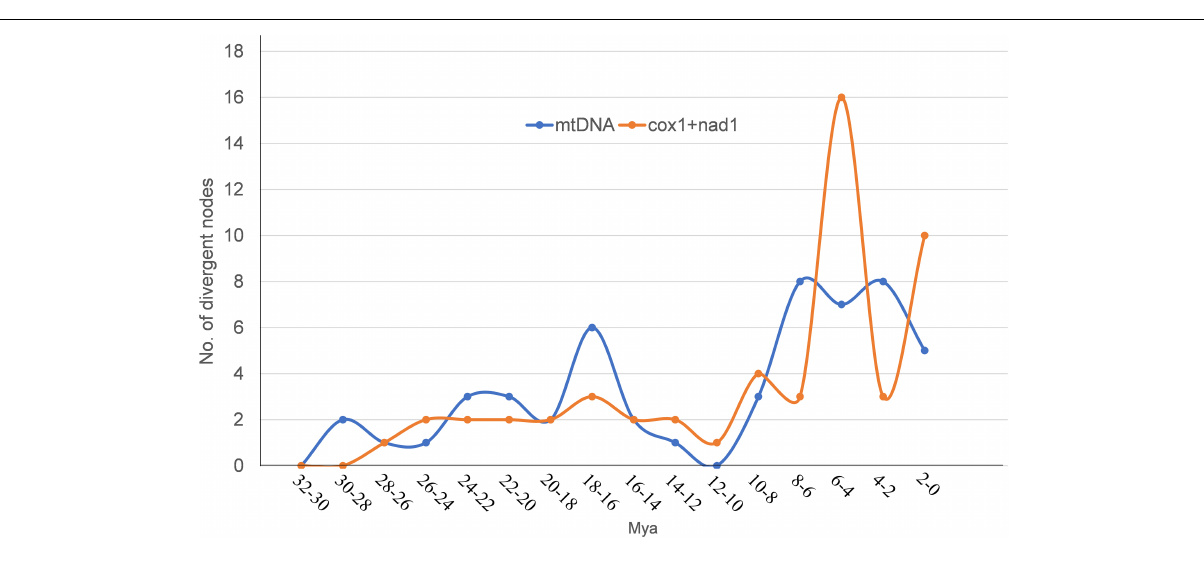
previous record of Paranoplocephala spp. and Mosgovoyia